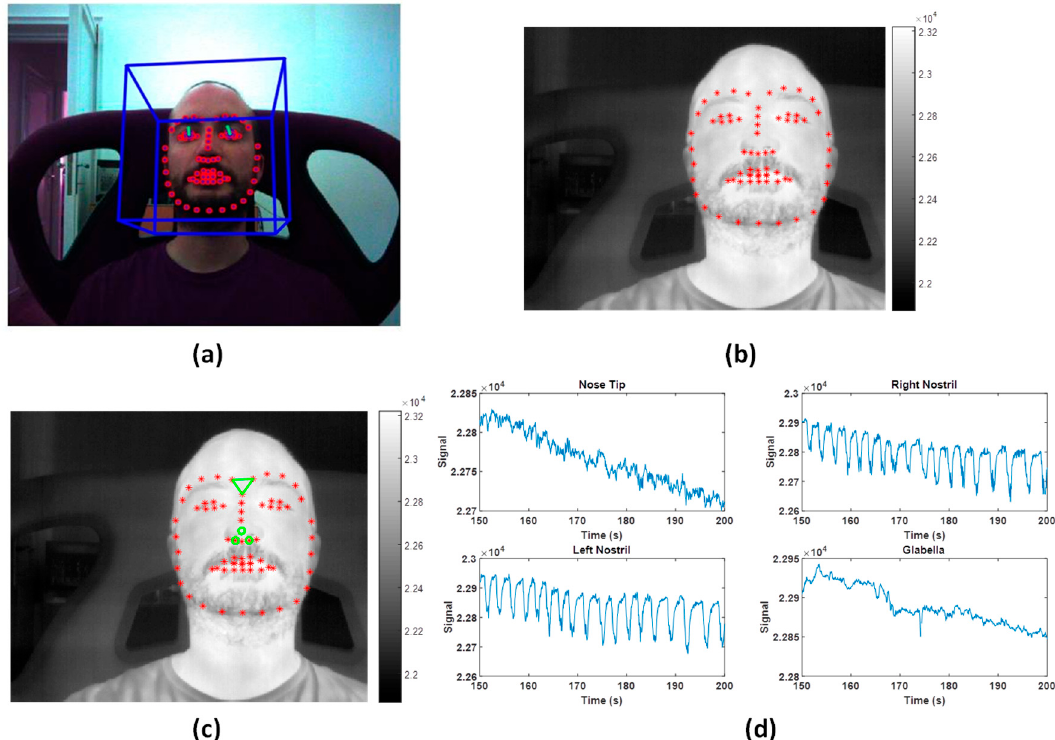
Figure 4. ( a ) Facial landmark identification in the visible image by OpenFace; ( b ) facial landmark identification in the corresponding thermal image applying the geometrical transformation obtained from the optical co-registration process; ( c ) Regions Of Interest (ROIs) identification (nose tip, right and left nostrils, glabella); ( d ) average thermal signals extracted from the ROIs in an exemplificative time window of 50 s. Notice the breathing signal is clearly appreciable from the right and left nostrils’ average thermal signals plots.